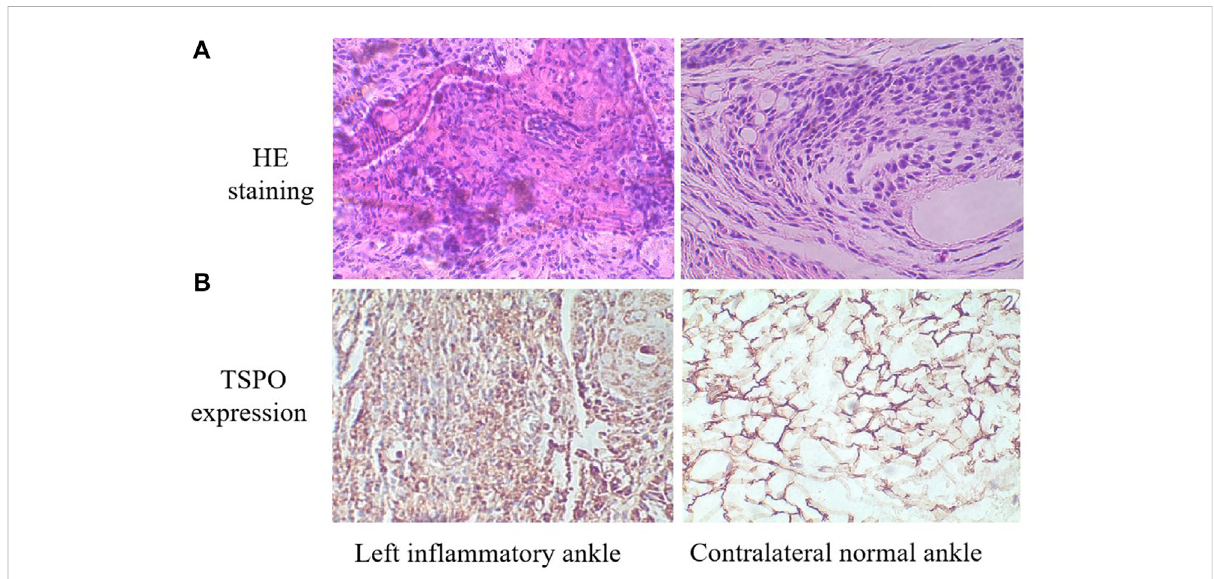
FIGURE 13 (A) HE staining of the left in fl ammatory ankles and contralateral normal ankles (×100). (B) The expression of TSPO on the left in fl ammatory ankles and contralateral normal ankles by immunohistochemical analysis